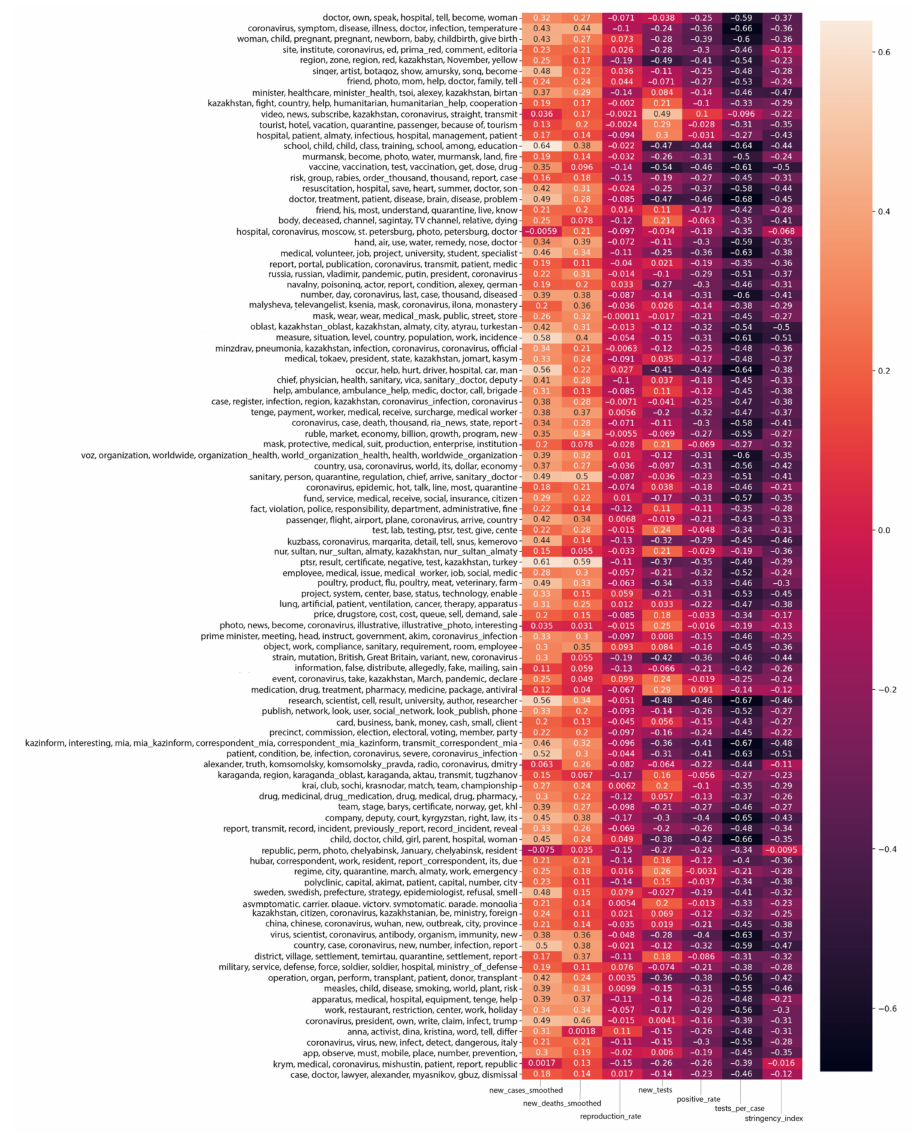
Figure A15. Correlation matrix between thematic clusters expressed as sets of the most rele- vant words (vertical) and pandemic indicators (bottom horizontal: variables new_cases_smoothed, new_deaths_smoothed,